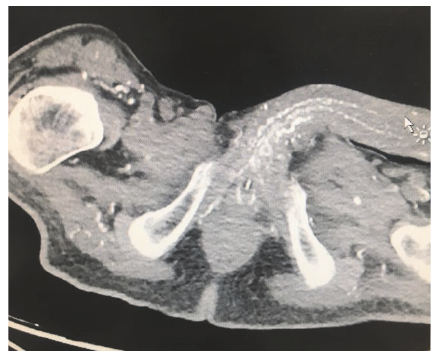
Figure 4: Partial penectomy.